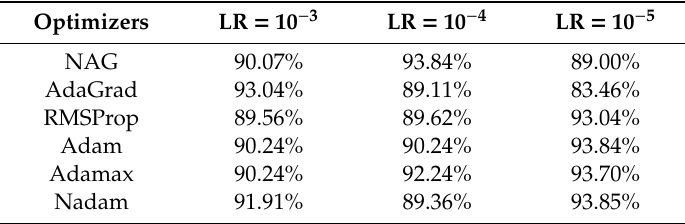
Table 4. Results obtained with the ResNet architecture. Where LR stands for learning rate; NAG represents Nesterov momentum; AdaGrad represents the adaptive gradient optimizer; RMSProp represents the root mean square propagation optimizer; Adam represents adaptive moment estimation optimizer; AdaMaxrepresentsmaximumadaptivemomentestimationoptimizer; andNadamrepresents Nesterov and Adam optimizer.